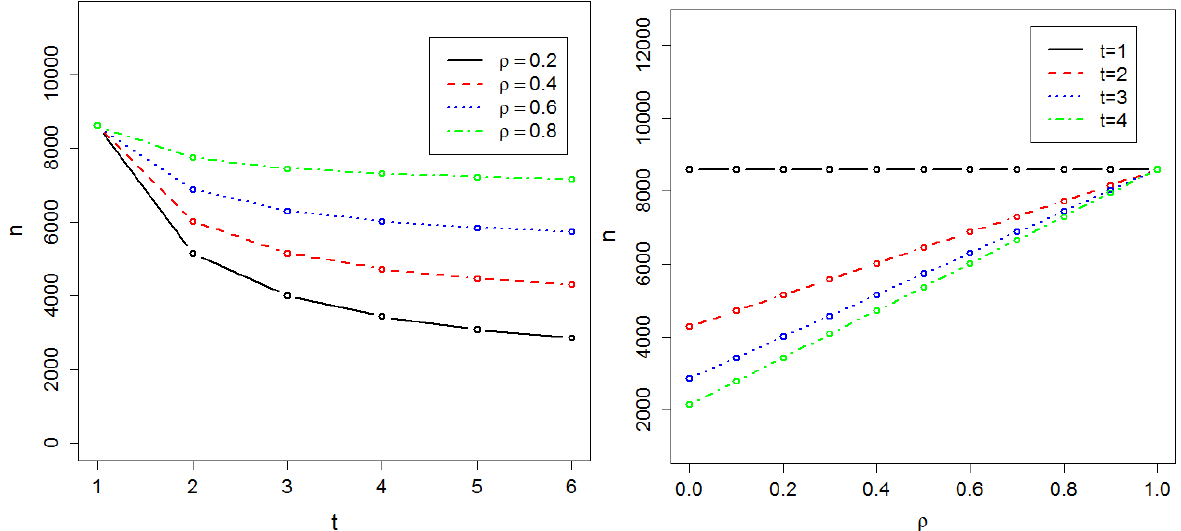
Figure 1. Required sample size in the absence of population substructure. The sample size is indicated by n . The required sample size to achieve 0.8 power at the significance level α = 10 −8 has been calculated as a function of t , the number of time points, and ρ, the correlation between measurements at two different